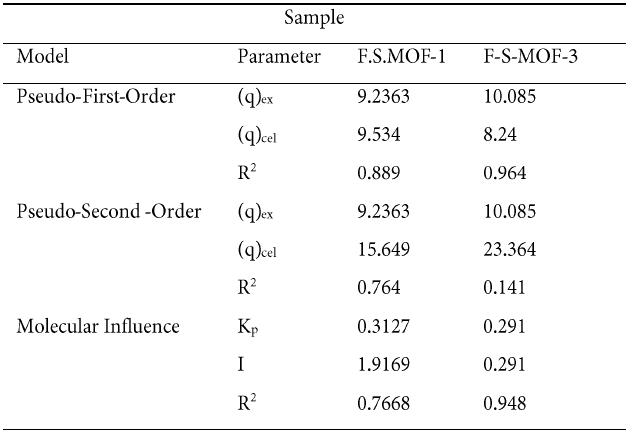
Table 6. Values of coefficient of determination R 2 and rate of degradation and the amount of degradation for each of the three kinetic models